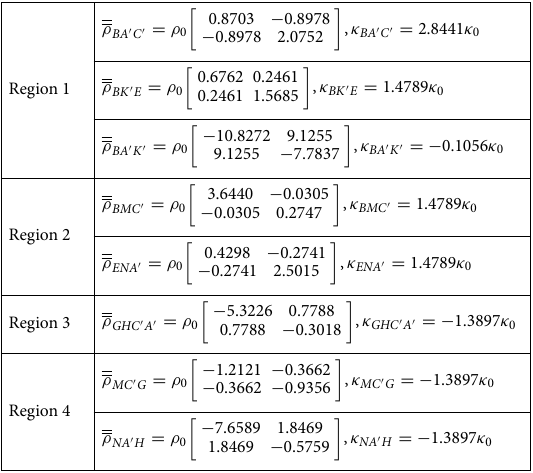
Table 1. The constitutive materials of the NCAC’s regions.